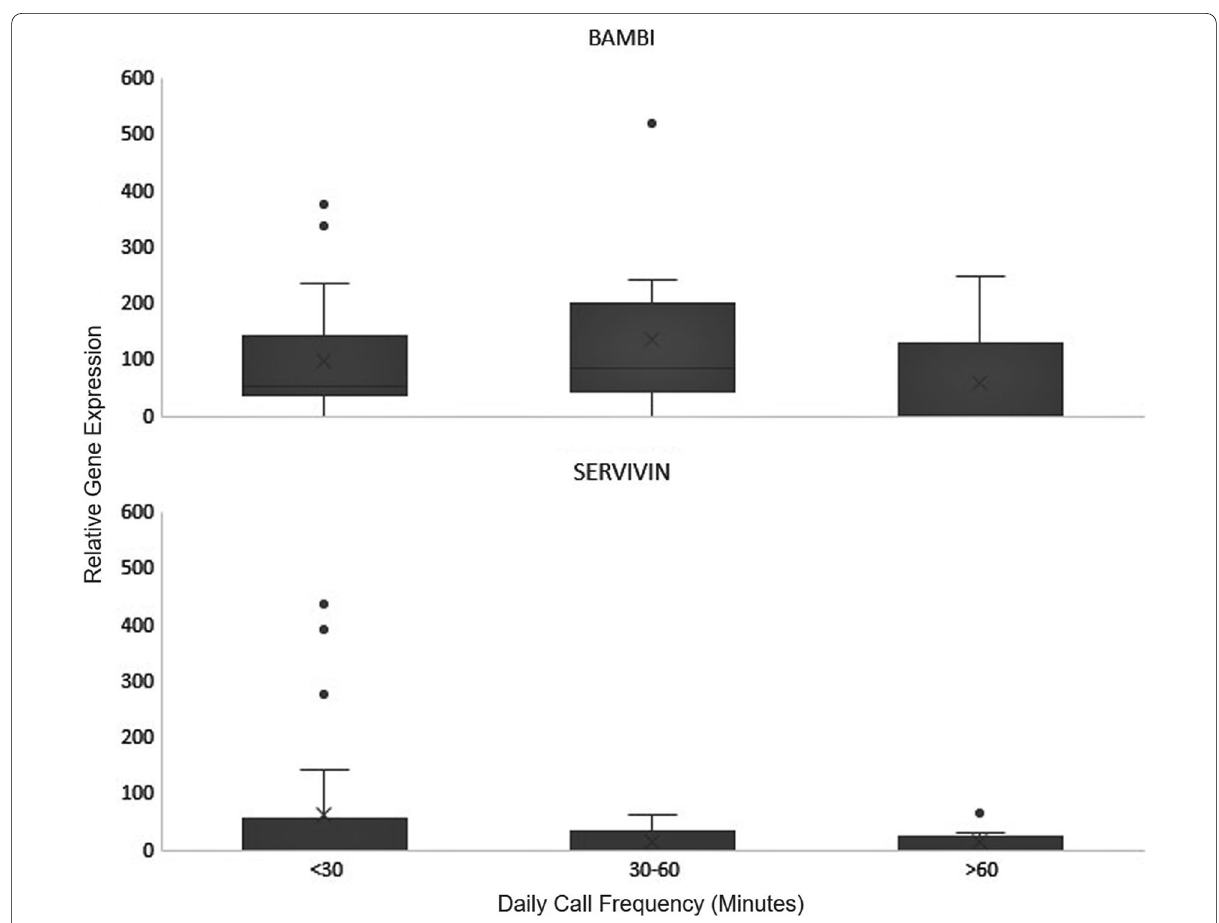
Fig. 3 Real‑time PCR analysis of the relative gene expression (2 − ΔΔ C T ) in the buccal cells of mobile phone users in relation to daily call duration (Min). Data are reported as mean SE ratios of relative expression ±